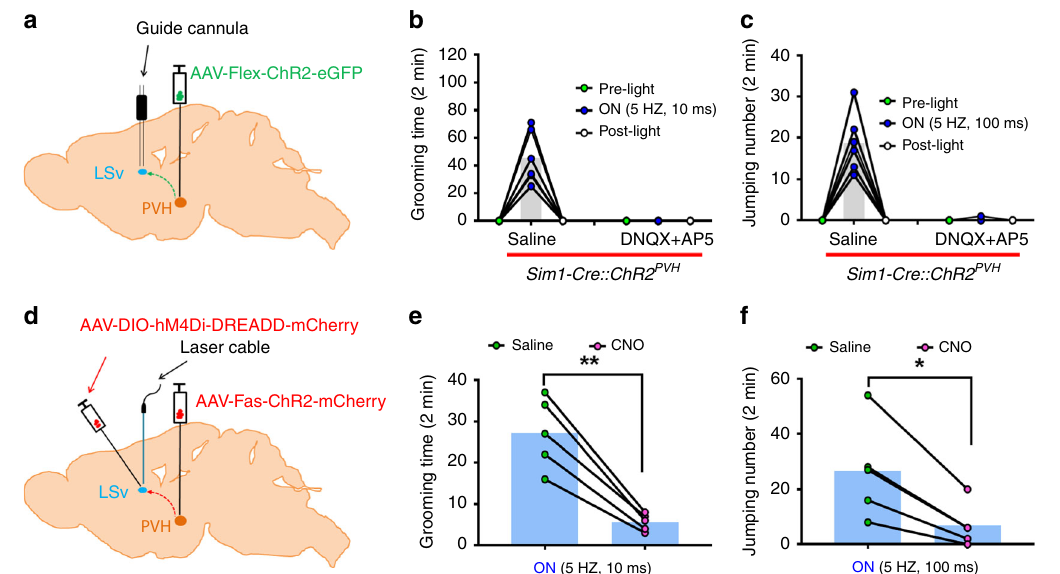
Fig. 3 LSv neurons mediate the effect of activation of PVH → LSv. a – c The effect of blocking LSv glutamate receptors on behavior. A paradigm depicting the experimental strategy using male Sim1-Cre mice a and the effect on self-grooming b and jumping c by infusion of saline or glutamate receptor antagonists DNQX + AP5 to LSv 5 mins prior to behavioral testing. d – f Vgat-Cre male mice with AAV-Fas-ChR2-eGFP ( “ Cre-off ” ) delivery to PVH, AAV-DIO-hM4Di- EREADD-mCherry delivery to LSv, and optic fi ber implantation targeting LSv d were used for self-grooming ( e n = 5, p = 0.0021) and jumping assays ( f , n = 5, p = 0.0105) in response to saline and CNO treatment. PVH: paraventricular hypothalamus; LSv: ventral part of lateral septum; aca: anterior commissure area; 3 V: the third ventricle; AcbSh: accumbens shell. * p < 0.05, ** p < 0.01, paired student ’ s t tests e ,